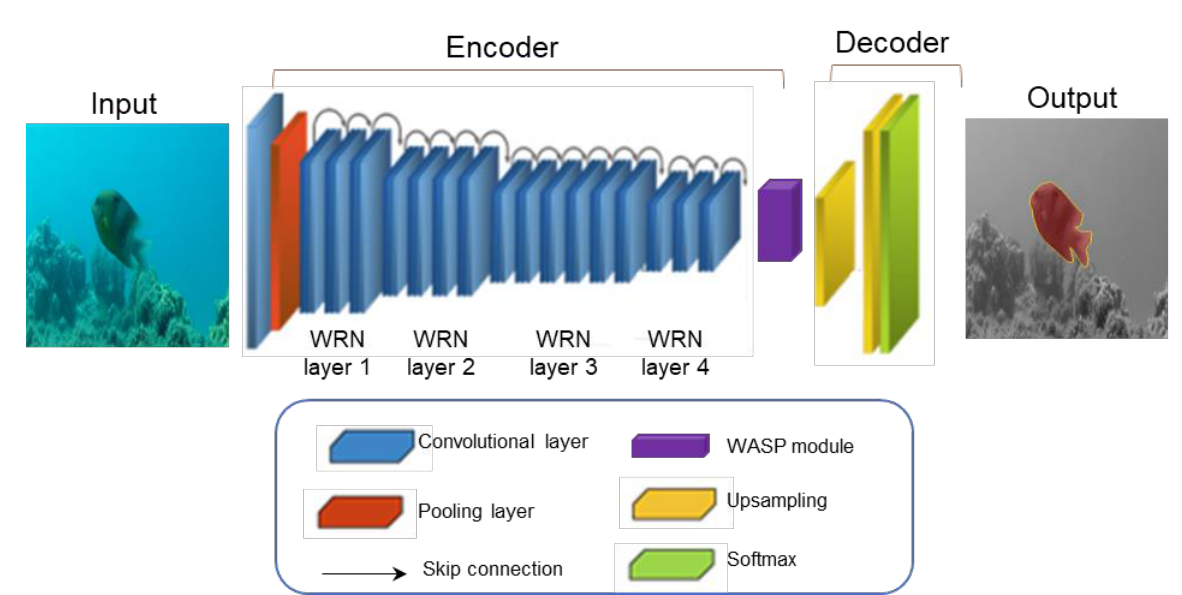
Figure 3 . The proposed FCN-WRN-WASP network for fish